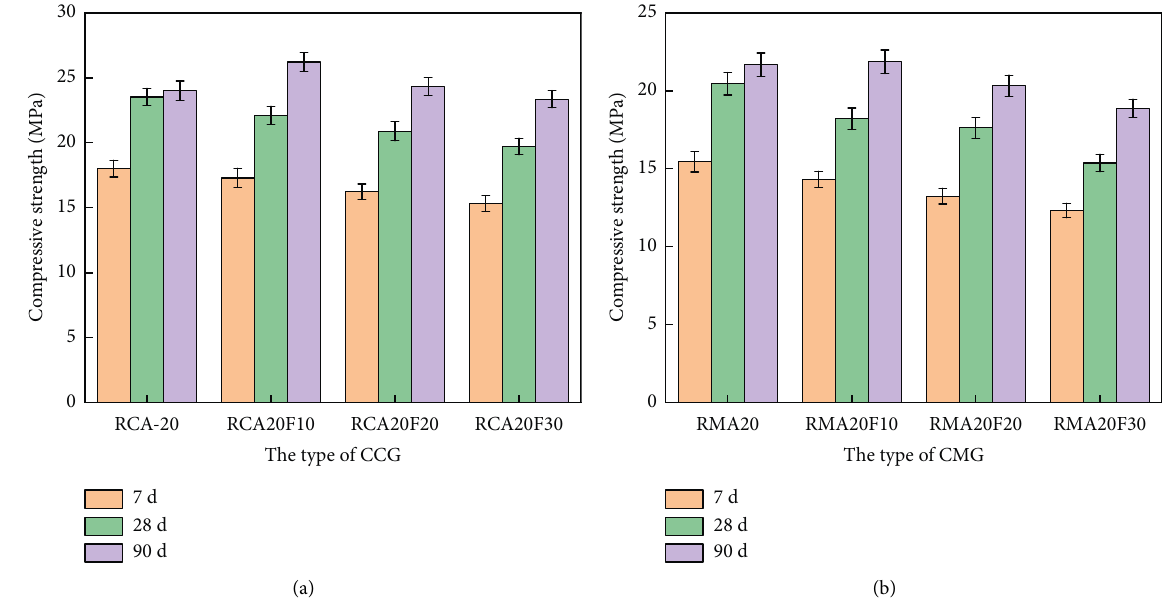
Figure 6: The compressive strength of CCG and CMG with different content of fly ash. (a) CCG, (b)